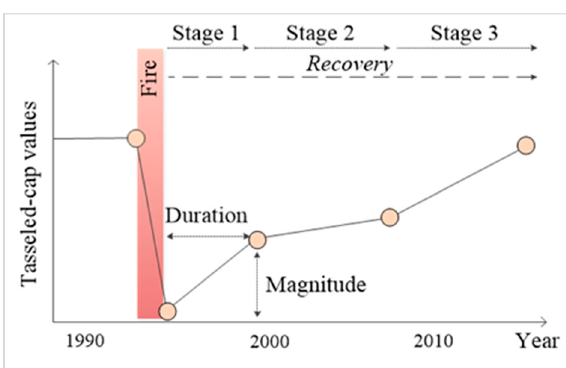
Figure 4. Example of a fitted trajectory.